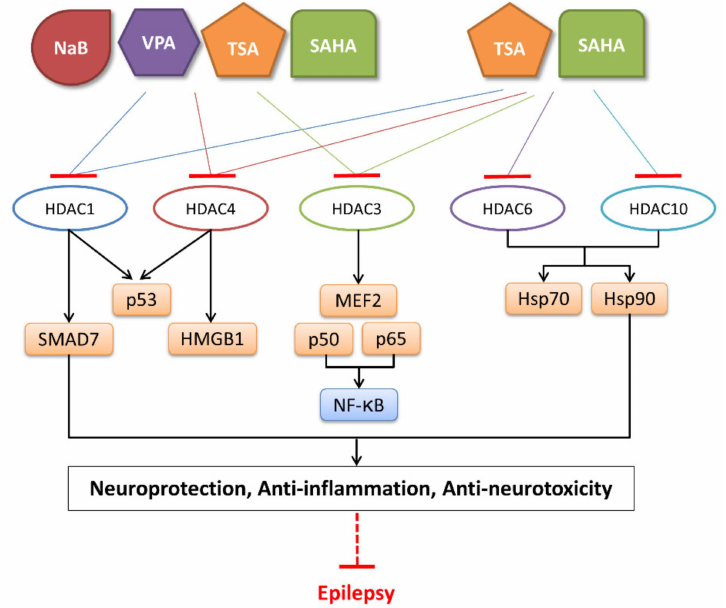
Figure 2. The applications of HDACi in epilepsy treatment. The HDACi that have been used in animal models of epilepsy and clinical treatment in humans and their potential targets are illustrated. NaB and VPA inhibit HDAC1, 3, and 4 in epilepsy models, while TSA and SAHA broadly target HDAC1, 3, 4, 6, and 10. SMAD7, HMGB1, and p53 are substrates of HDAC1 and HDAC4. MEF2 and NF- κ B (p50 and p65) are substrates of HDAC3. Hsp70 and Hsp90 are substrates of HDAC6 and HDAC10. By regulating the acetylation of the above substrates, HDACi might promote neuroprotective, anti- inflammatory, and anti-neurotoxic effects to inhibit